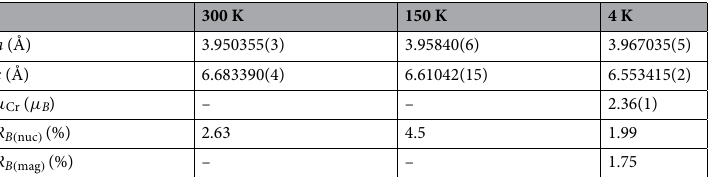
Table 3. Comparison of results from neutron powder diffraction on polycrystal LiCrTe 2 at three different temperatures. Nuclear space group P 3 m 1 (#164) and magnetic (Shubnikov) space group P c 3 c 1 (#165.96), i.e. Ŵ 3 representation shown in Table 2 and Fig.